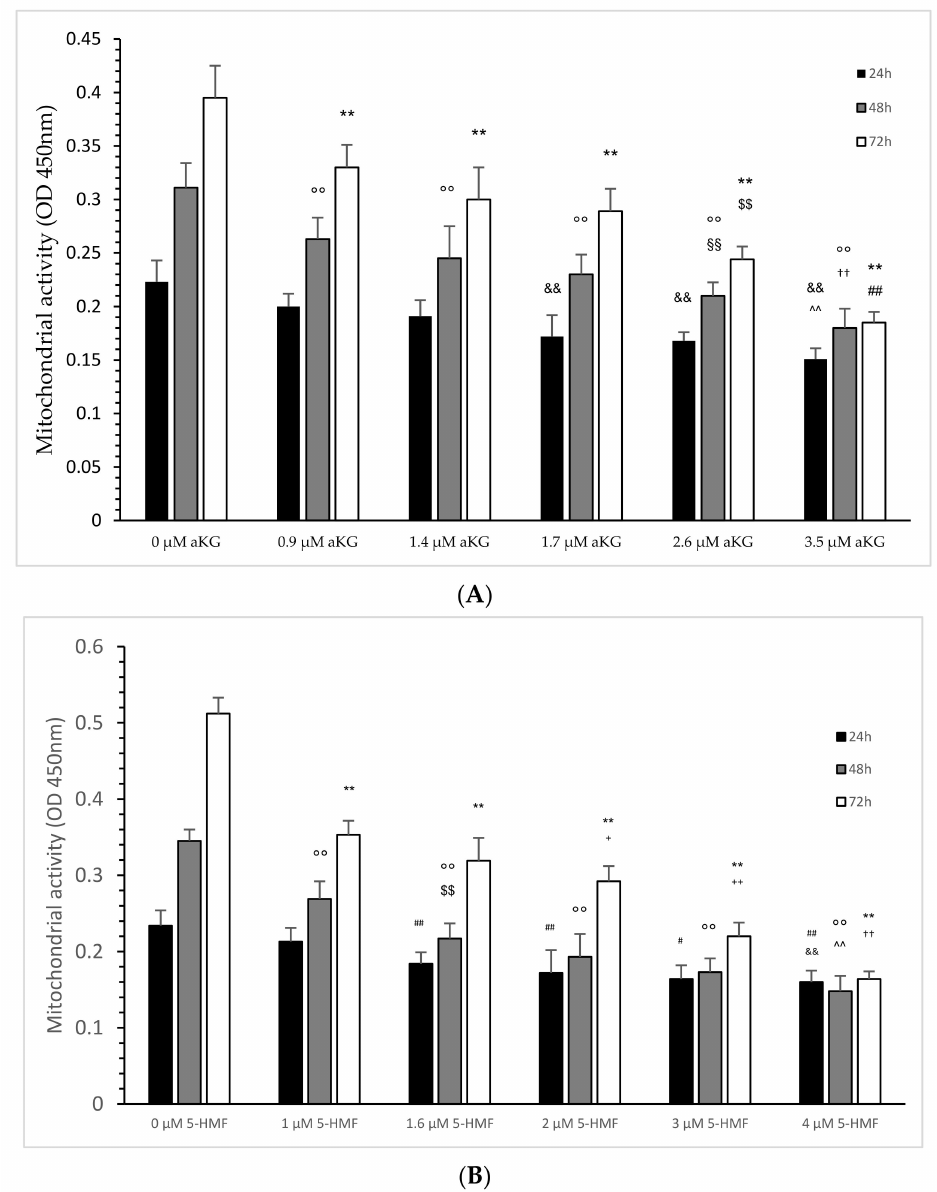
Figure 4. Mitochondrial activity of the Jurkat cell line in the absence or presence of different